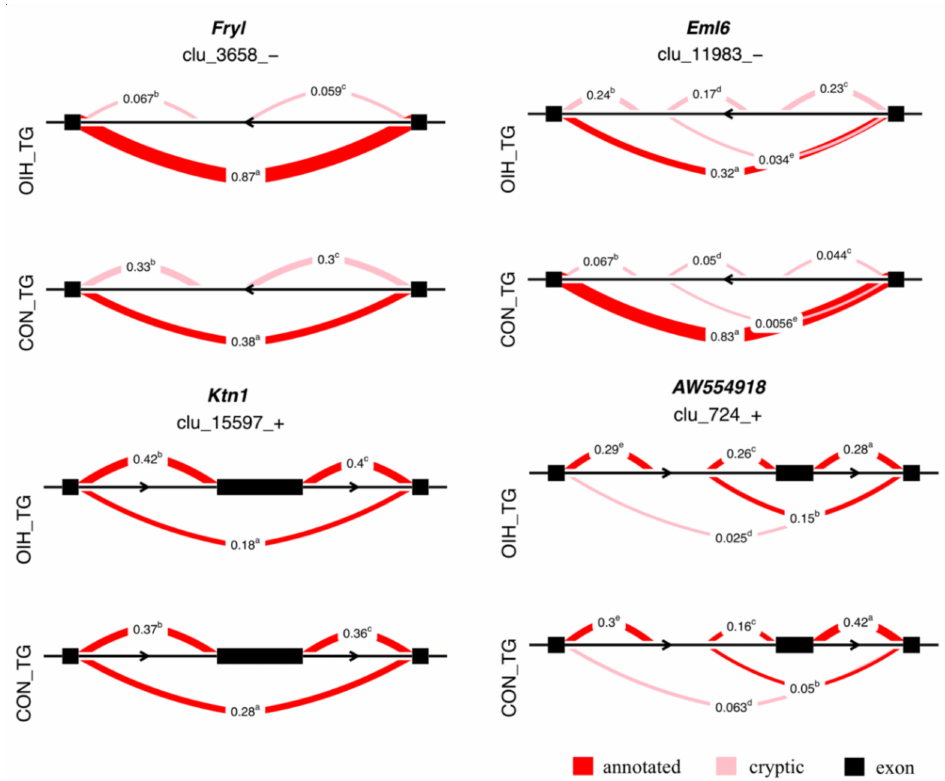
Figure 2. Examples of differential spliced genes (maximum | ∆ PSI| > 0.1, P -value < 0.005) between opioid-induced hyperalgesia (OIH) and control (CON) mice in the trigeminal ganglia (TG). Genes included Fryl = FRY like transcription coactivator, Eml6 = EMAP like 6, Ktn1=kinectin 1, and expressed sequence AW554918. The semicircles indicate the clusters of introns corresponding to transcript isoforms, the numbers represent the relative proportion of each intron cluster within OIH and control, and the superscript denotes different clusters. Table 4. Enriched PANTHER pathways among genes presenting absolute or relative differential